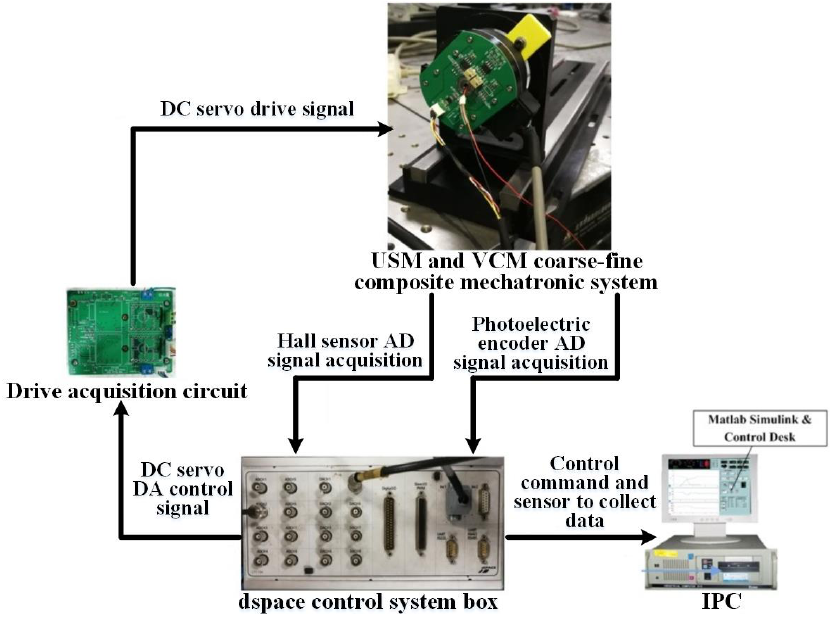
Figure 8. Ultralight VCM performance comprehensive test.